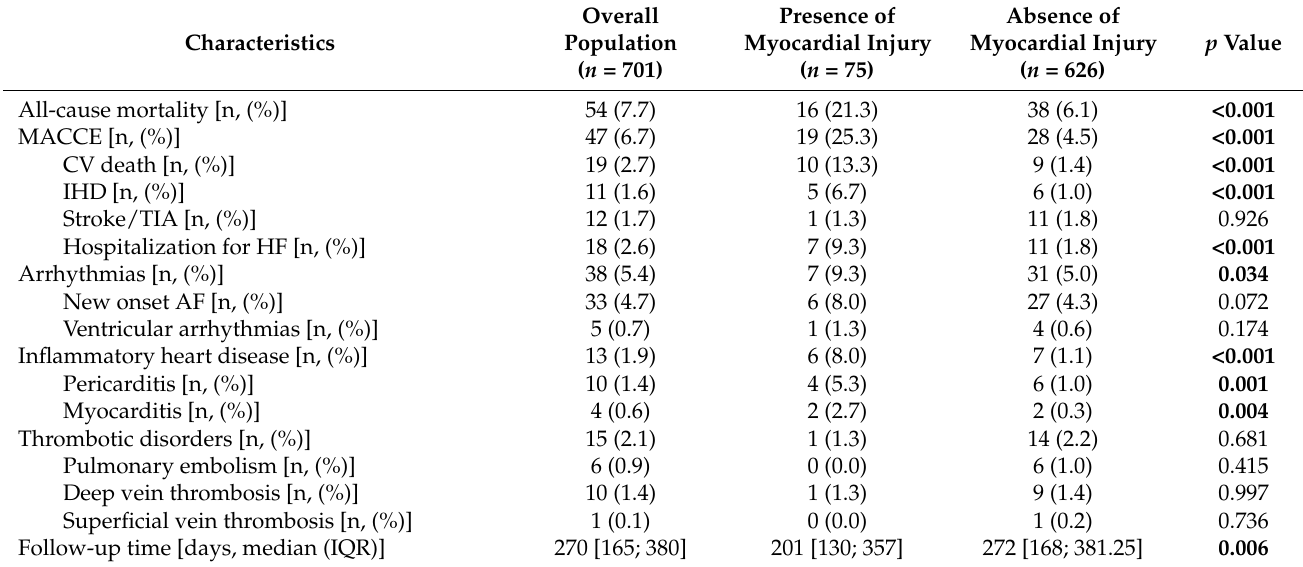
Disease-2019. Table 2. Clinical outcomes in the overall population and according to the presence or absence of myocardial injury during the index hospitalization for